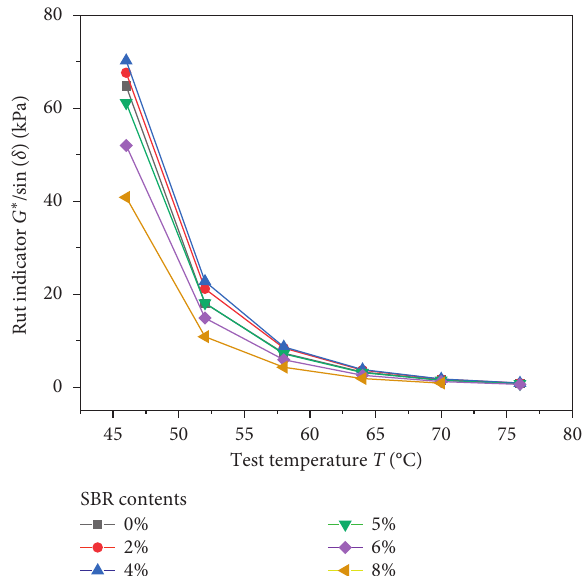
Figure 7: The variation patterns of rutting indicators and test temperatures.